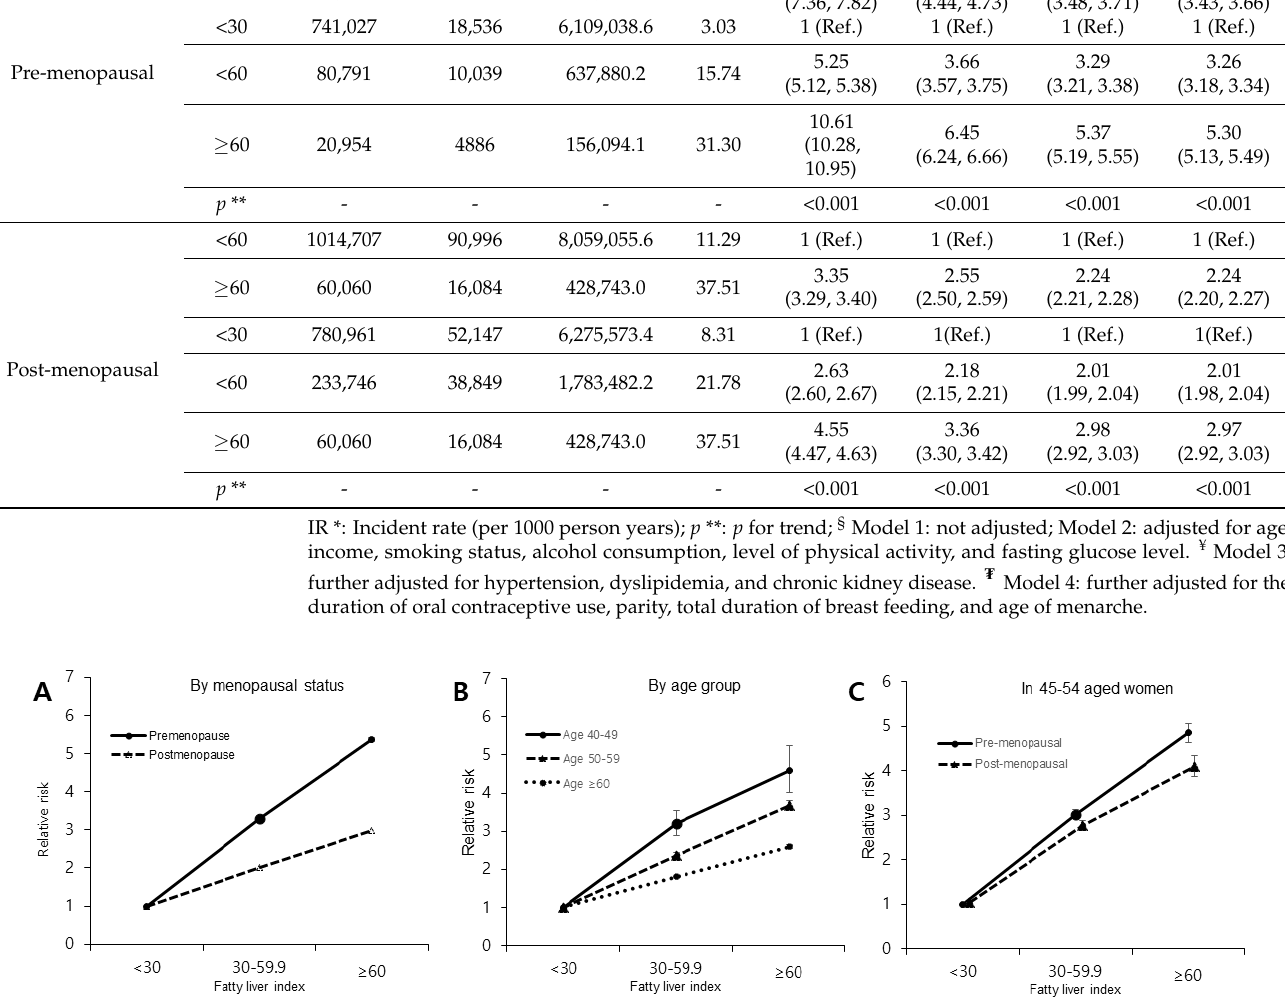
Table 4. Associations between fatty liver index and type 2 diabetes mellitus risk according to age.